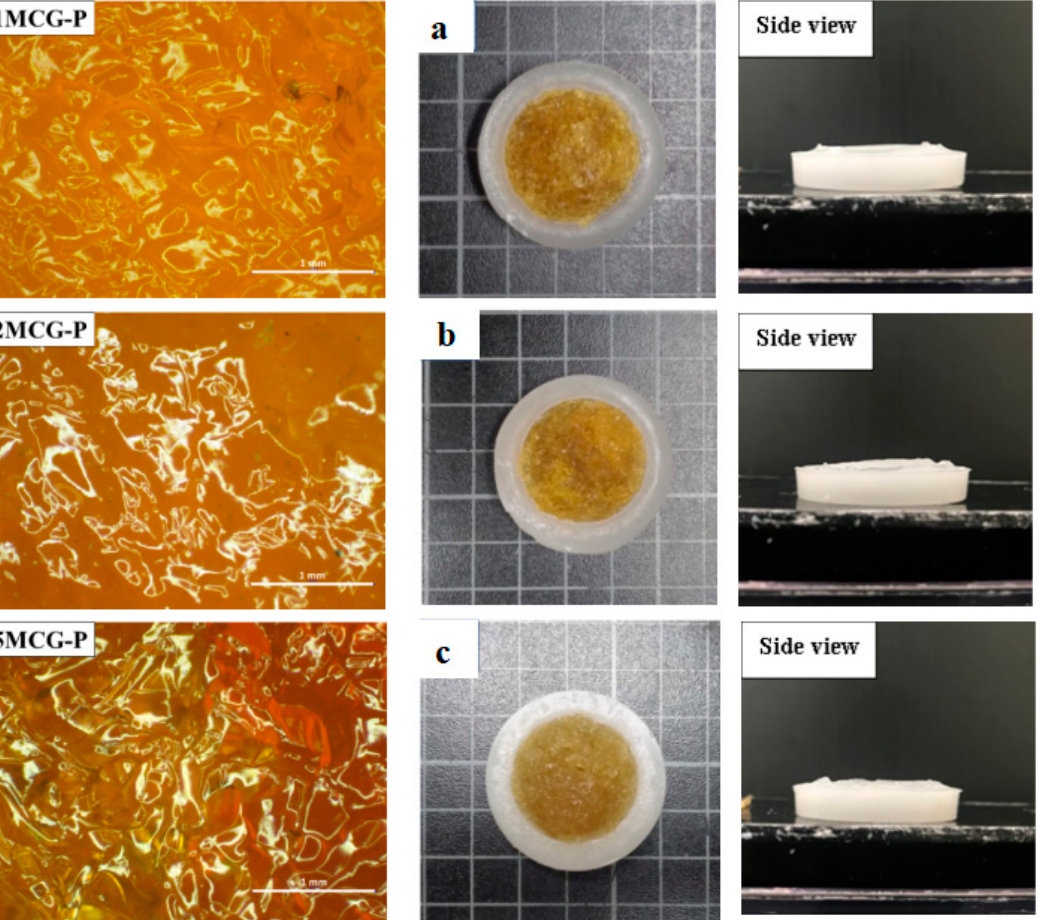
Figure 6. Images of surface of CS/Gel/MMT/PCL bone scaffolds of ( a ) 1MCG-P, ( b ) 2MCG-P, and ( c ) 5MCG-P.